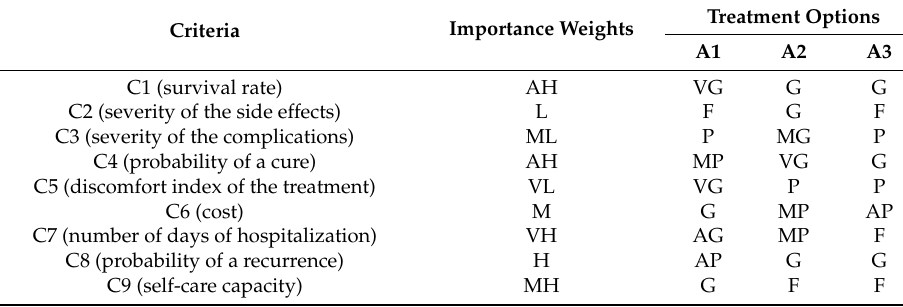
Table 4. The criterion importance weights and therapeutic